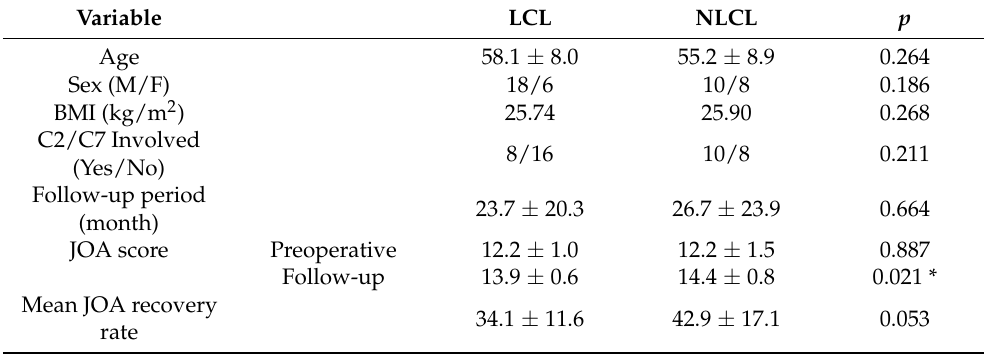
Table 2. Comparation of basal characteristics and clinical outcomes between LCL and NLCL groups.